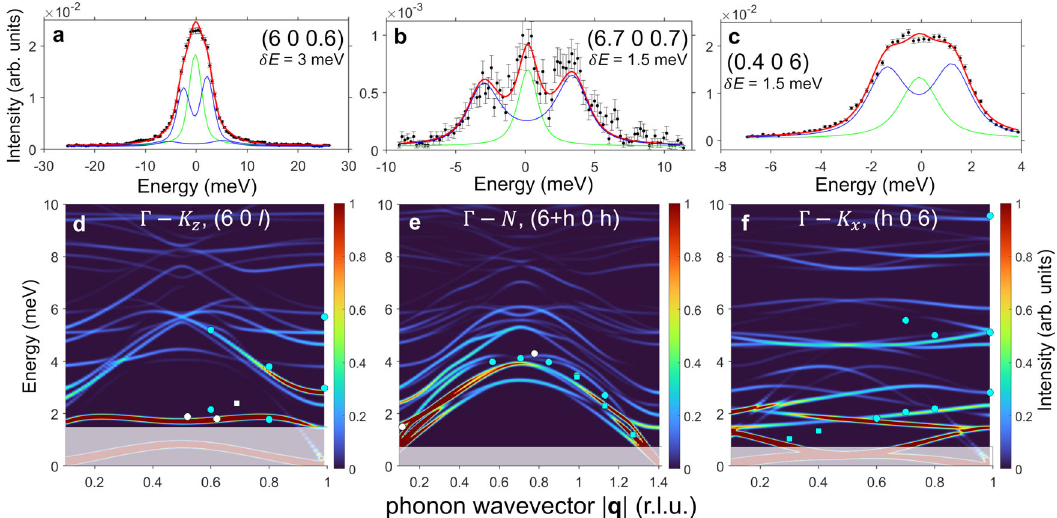
Fig. 2 | Detecting very-low-energy phonon modes. In a – c we show ID28 data on [VO(TPP)](blackscatters,witherrorbarsrepresentingtheSE)obtainedat T =300K witharesolutionof δ E =3meVfortransversescansalong Γ – K z ( Q =(6,0,0.6)),and with δ E =1.5 meV along Γ – N ( Q =(6.7,0,0.7)) and Γ -K x ( Q =(0.4,0,6)) symmetry directions, respectively (with error bars representing the SE). Solid red lines are resultsofa fi tobtainedwithID28customsoftwareFIT28,comprisingtheexcitation signals (blue lines) and the elastic one (green line). In d – f we show the IXS cross-